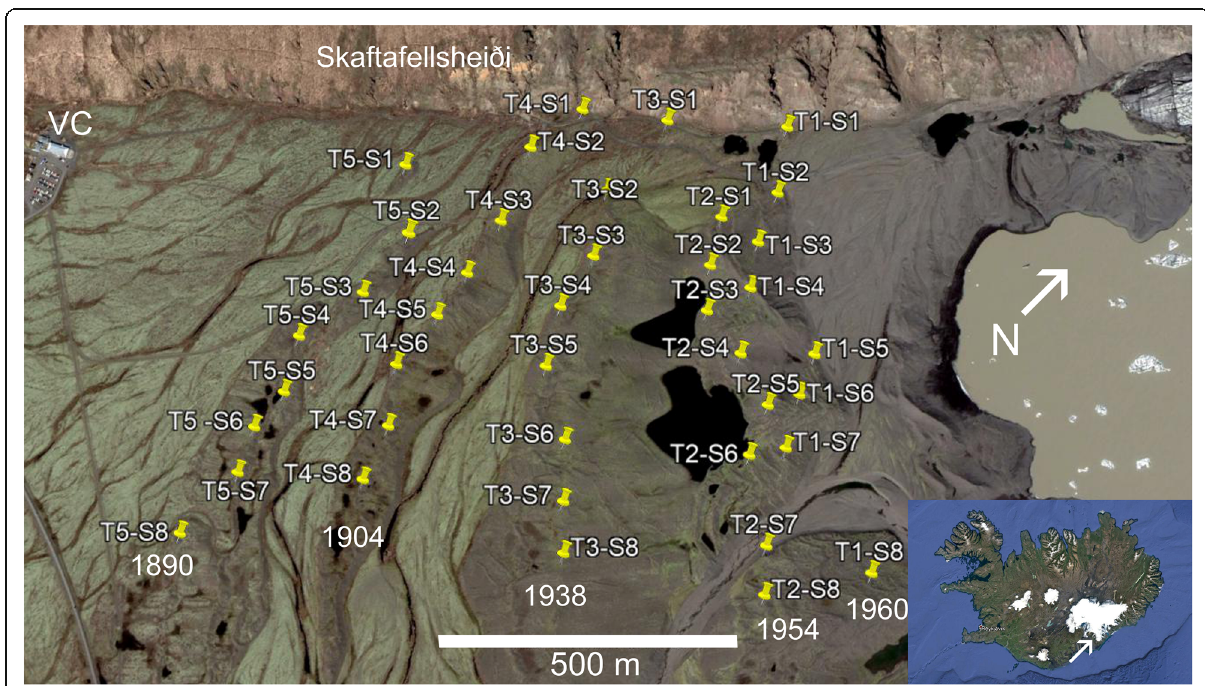
Fig. 1 Map of the Skaftafellsjökull foreland with the locations of all stations in the five transects marked. The dates represent the ages of the moraines on which each transect was located. Skaftafellsheiði is the ridge that borders the foreland to the northwest. Arrow on inset map indicates location of the field area. VC, park visitor center. The figure is adapted from data downloaded from Google Earth® (image